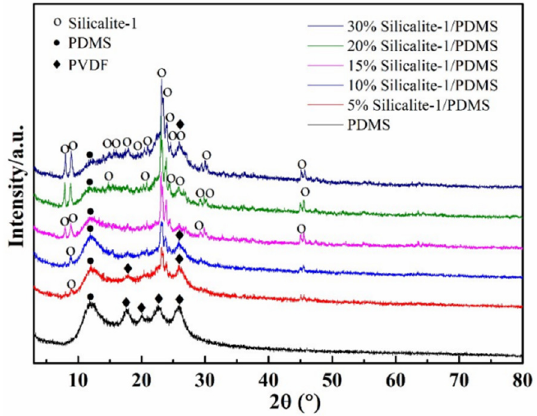
Figure 7. XRD patterns of the silicalite-1/PDMS/PVDF hybrid membranes with different silicalite-1 zeolites contents.